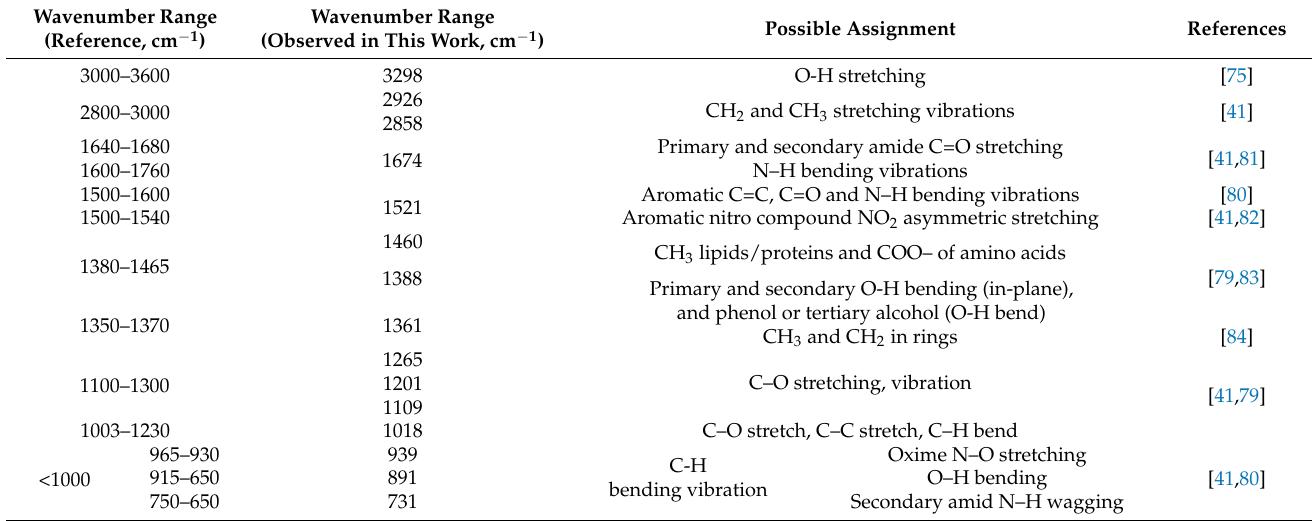
Table 12. Identification of main peaks and their respective possible